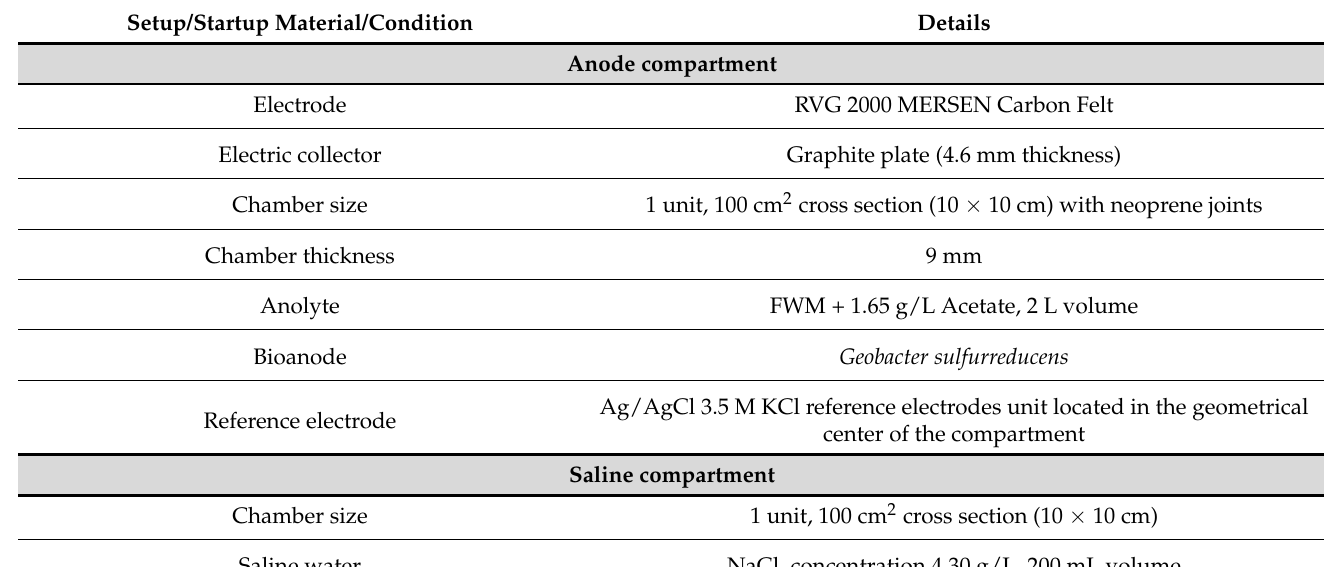
Table 1. Microbial desalination cell (MDC)